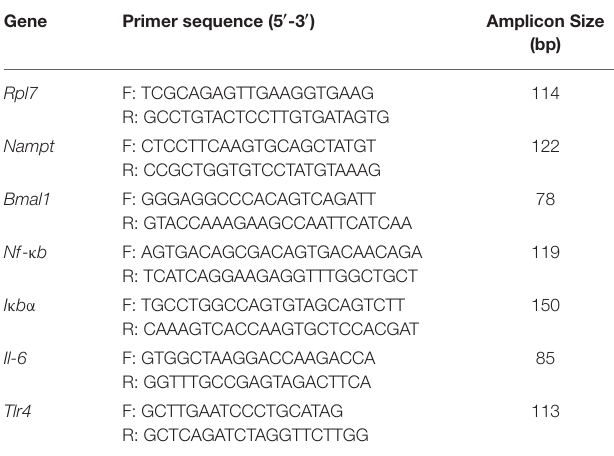
TABLE 1 | List of primers used for